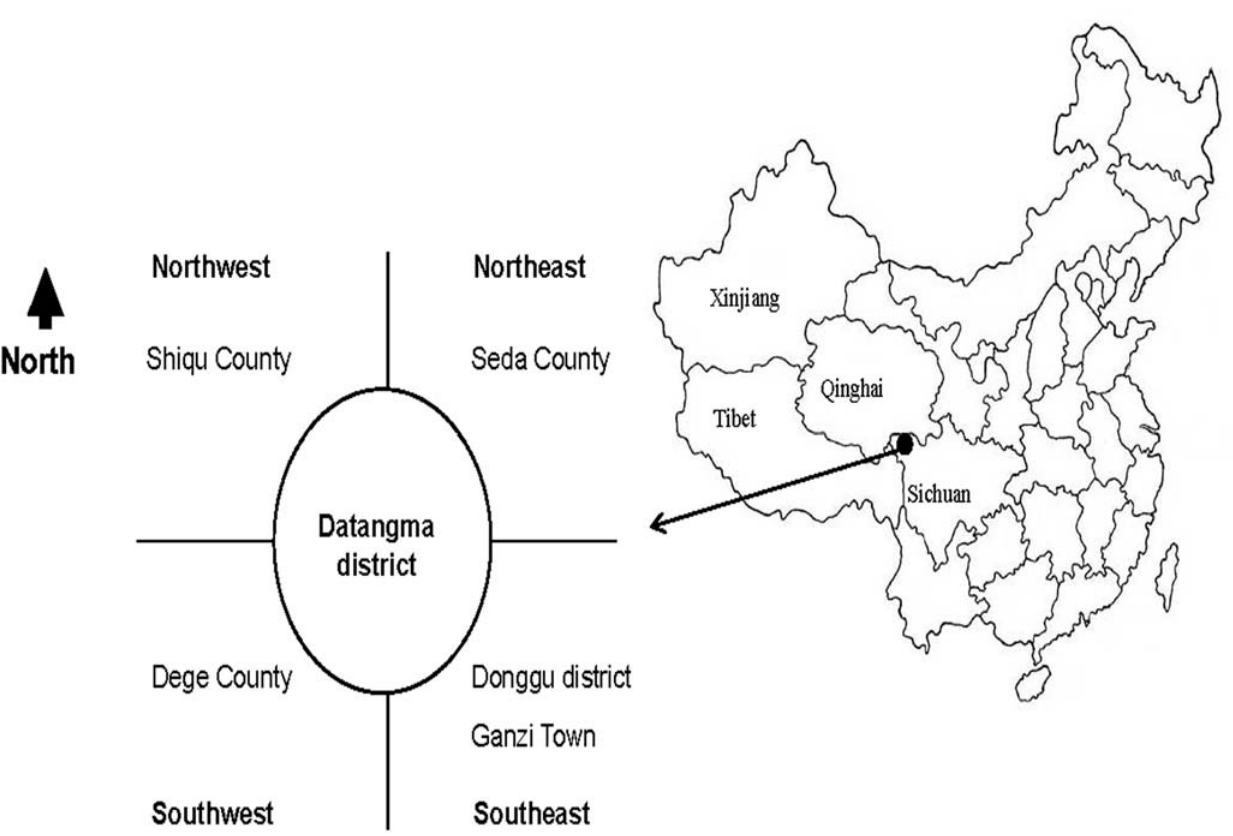
Figure 1. Map of China showing Datangma district in the northwest area of Ganzi Tibetan Autonomous Prefecture, Sichuan Province, China.